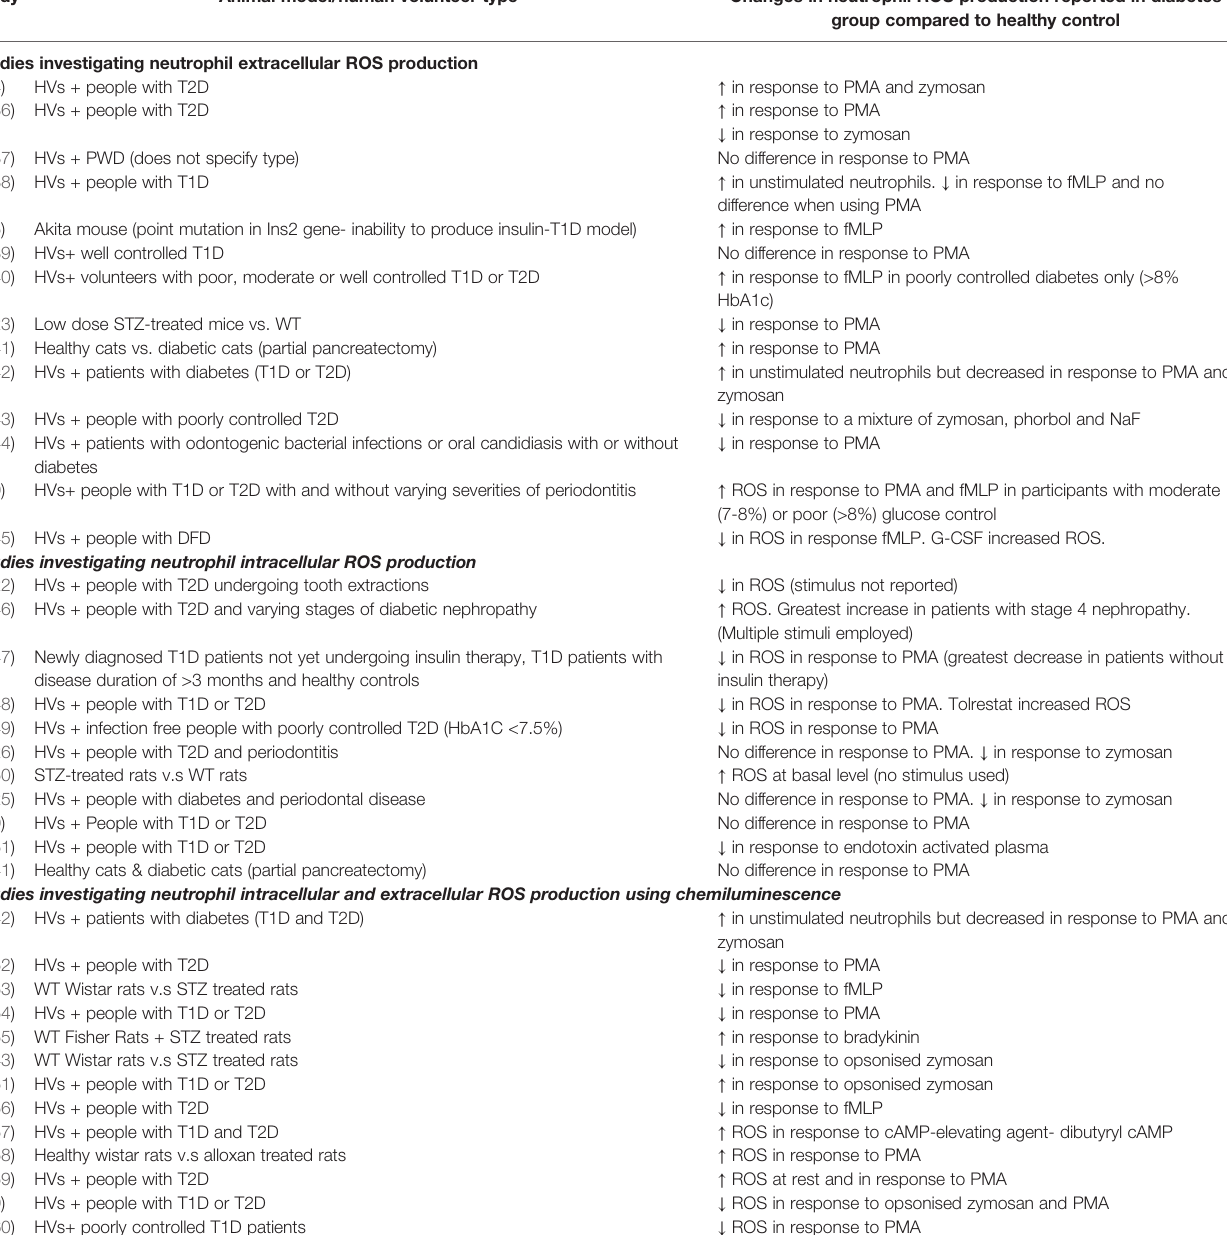
group compared to healthy control